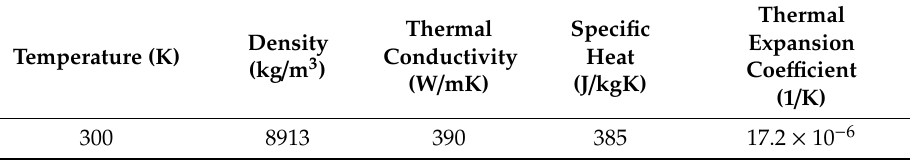
Table 6. Physical properties of electrodeposited OFHC.